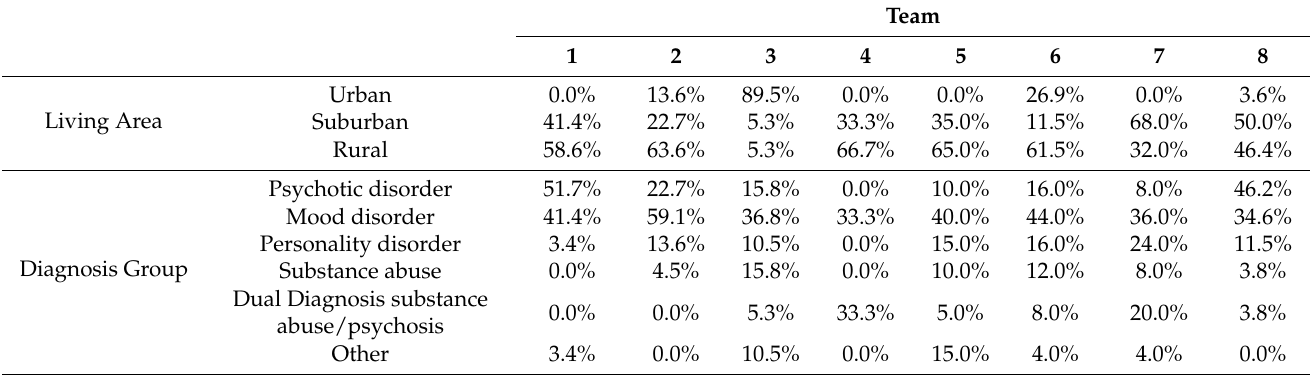
Table 2. Percentual distribution of patients’ living area and diagnosis groups within each team.